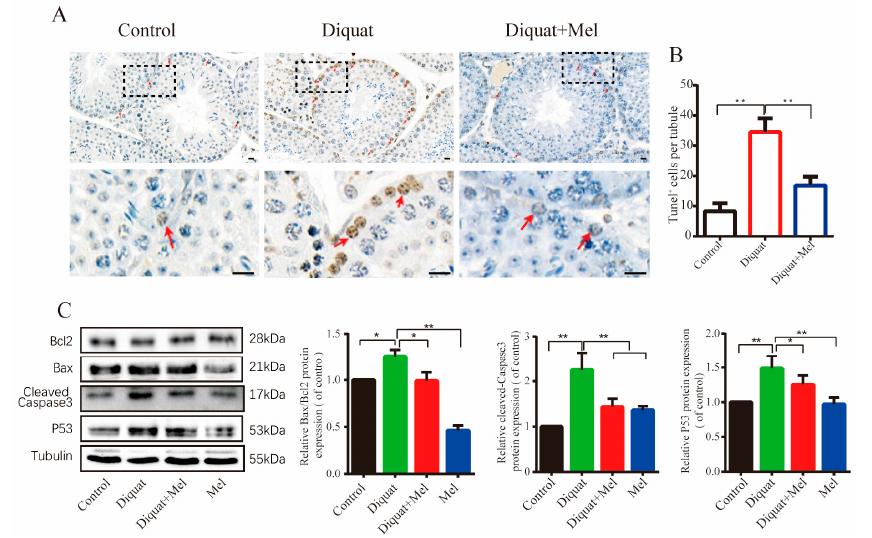
Figure 3. Melatonin attenuates diquat-induced apoptosis in mouse testes: ( A ) representative TUNEL staining photographs of testes in the control and diquat treatment groups with or without melatonin. TUNEL-positive cells denoted by arrowheads are presented in brown while the nucleus is stained blue. The squares represent the enlarged position in the following figure. Scale bars = 5 µ m; ( B ) quantitative analysis of the number of apoptotic cells; and ( C ) representative Western blotting and quantitative analysis of apoptosis-related markers, Bax/Bcl2, Cleaved-Caspase3, and P53 in the control, melatonin (10 mg/kg/d), diquat (10 mg/kg/d) or diquat combined with melatonin treatment groups. Data are presented as the mean ± SEM of at least three independent experiments. * p < 0.05, ** p < 0.01.